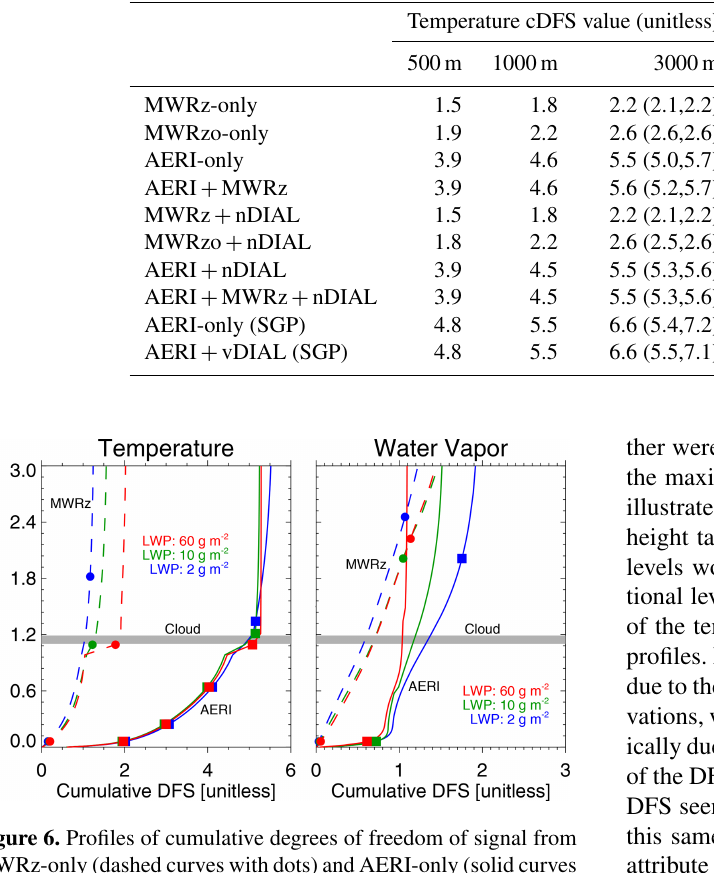
Table 3. Average cDFS values at three levels for temperature and humidity for the different instrument combinations used in this study. The passive-only retrievals are highlighted in gray, whereas the active + passive are in white. The values in parentheses at 3km show the 10th and 90th percentile at that height, thereby providing a measure of the amount of variability in these statistics for each retrieval.